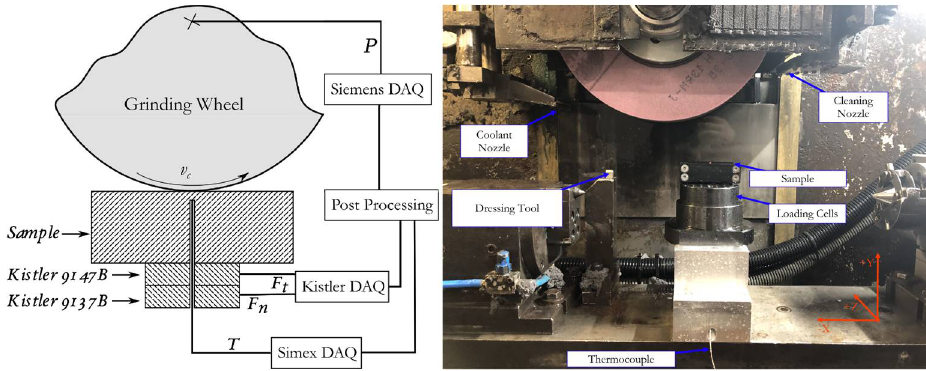
Figure 1. Sensor diagram and the internal configuration of the grinding machine.